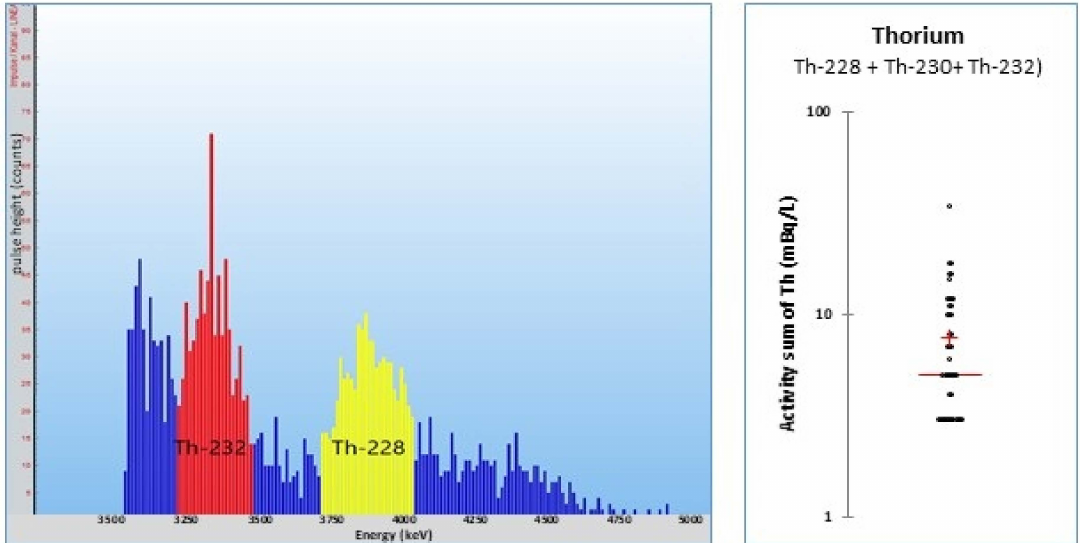
Figure 8. Left: THOREX extract of a ground water sample. Right: scatter diagram of the activity sum of the three thorium nuclides in mineral water samples